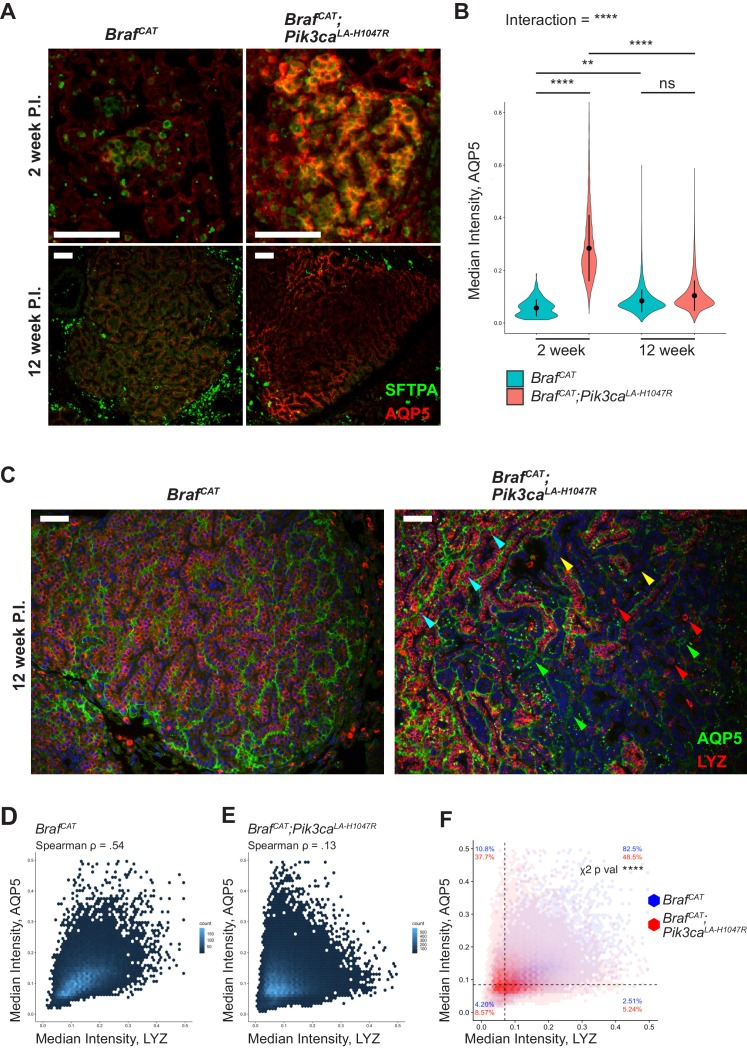
BRAFV600E/PI3KαH1047R and BRAFV600E driven tumors both show effects on differentiation status, with BRAFV600E/PI3KαH1047R driven tumors displaying more profound effects on identity.(A) BRAFV600E/PI3KαH1047R and BRAFV600E driven hyperplasia both show immunoreactivity of the AT1 marker, AQP5, 2 weeks post initiation with BRAFV600E/PI3KαH1047R driven hyperplasia showing enhanced immunostaining. BRAFV600E/PI3KαH1047R and BRAFV600E driven tumors also show immunoreactivity of AQP5 12 weeks post initiation with BRAFV600E/PI3KαH1047R driven tumors showing a more variable pattern of immunostaining. Scale bars = 100 um. (B) Quantitation demonstrating significant effect of PI3KαH1047R on AQP5 immunoreactivity in BRAFV600E driven tumors 2 weeks post initiation. No difference seen in AQP5 immunoreactivity between BRAFV600E/PI3KαH1047R and BRAFV600E driven tumors 12 weeks post initiation. This appears to be the result of a slight increase in AQP5 immunoreactivity between 2 and 12 weeks in BRAFV600E driven tumors and a more dramatic decrease in AQP5 immunoreactivity between 2 and 12 weeks in BRAFV600E/PI3KαH1047R driven tumors. ANOVA p<1e-5, multiple comparisons done by Tukey’s Honest Significant Difference test, ****: p<1 e −5, **p=0.0014. (C) BRAFV600E driven tumors display widespread immunoreactivity to both AQP5 and the AT2 marker, LYZ, 12 weeks post initiation. BRAFV600E/PI3KαH1047R driven tumors show cells with widely varied expression of differentiation markers, including AQP5+, LYZ+ (Cyan arrows); AQP5-, LYZ+ (Red arrows); AQP5+, LYZ- (Green arrows); and AQP5-, LYZ- (Yellow arrows) cells. Scale bars = 100 um. (D) BRAFV600E driven tumors show relatively high association between AQP5 and LYZ immunoreactivity (Rho = 0.54). (E) BRAFV600E/PI3KαH1047R driven tumors show relatively low association between AQP5 and LYZ immunoreactivity (Rho = 0.13) (F) Overlay of BRAFV600E/PI3KαH1047R and BRAFV600E driven tumors 12 weeks post initiation. Dashed line for each marker drawn at mean - one standard deviation of BRAFV600E driven tumors. BRAFV600E/PI3KαH1047R driven tumors show fewer AQP5+, LYZ + cells, most strongly accounted for by an increase in AQP5+, LYZ- cells, but with increases also seen in AQP5-, LYZ + and AQP5-, LYZ- cells. Chi square test associates genotype with distribution, p val <1e-5.10.7554/eLife.43668.027Figure 5—source code 1.R script to perform statistics on Figure 4—source data 1, as well as plot these results.10.7554/eLife.43668.028Figure 5—source code 2.Cellprofiler pipeline to quantify raw images from BRAFV600E/PI3KαH1047R and BRAFV600E driven tumors, producing Figure 5—source data 1.10.7554/eLife.43668.029Figure 5—source data 1.Cellprofiler output quantifying AQP5 and LYZ immunofluorescence in BRAFV600E/PI3KαH1047R and BRAFV600E driven tumors.